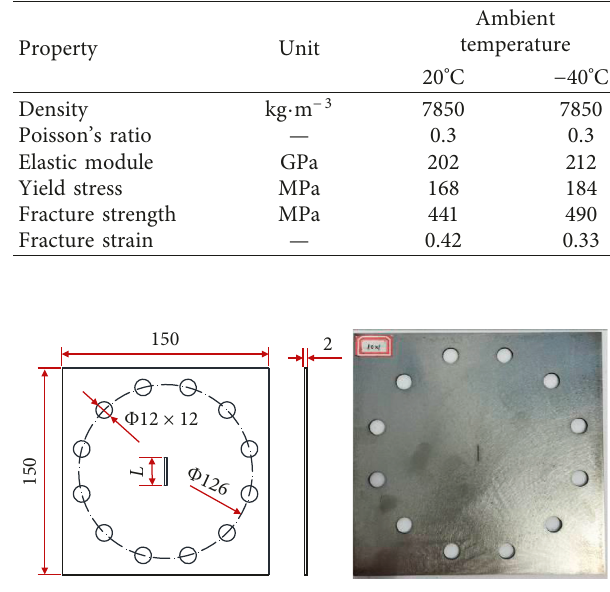
Figure 4: The cracked square specimen (unit: mm).